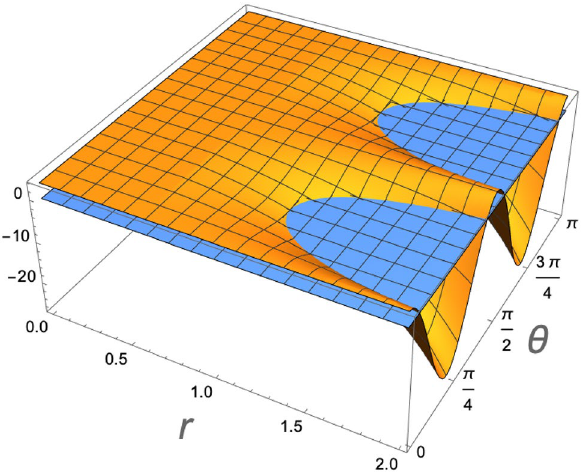
Figure 2. Entanglement of the ions logitudinal vibrational modes as a function of the squeezing parameter of 2 r ion 2, and the interaction θ = gt . Only for 2 ( ¯ n 2 + 1 / 2 ) ≤ e , is that the vibrational mode 2 is non-classical, allowing that the evolution (34) entangle the ions (represented by the negative values of the vertical axis). Maximal entanglement occurs at θ = π/ 4 (or 3 π/ 4 ), corresponding to a 50:50 beam-splitter.